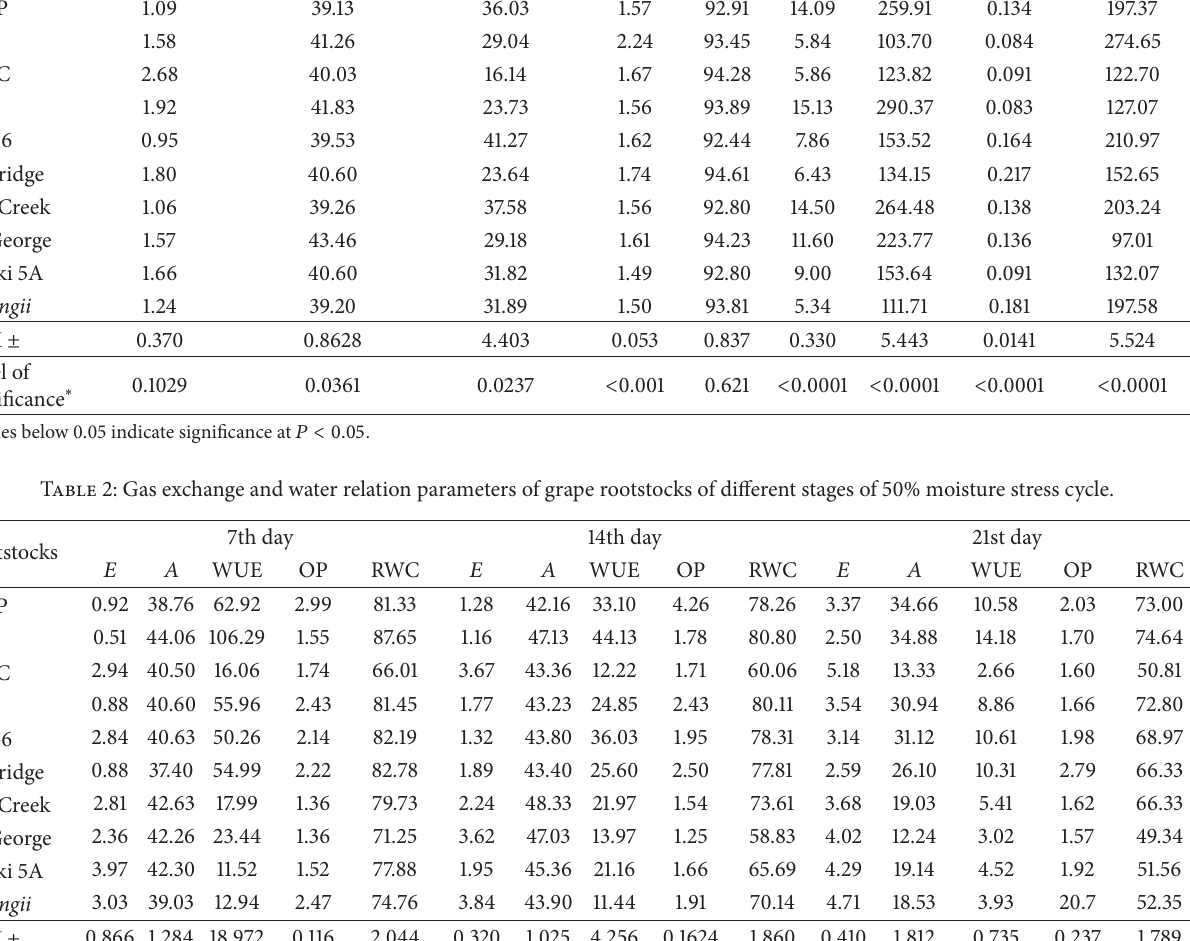
Table 1: Gas exchange parameters, water relations, and biochemical parameters in grape rootstocks without stress before imposition of moisture stress.